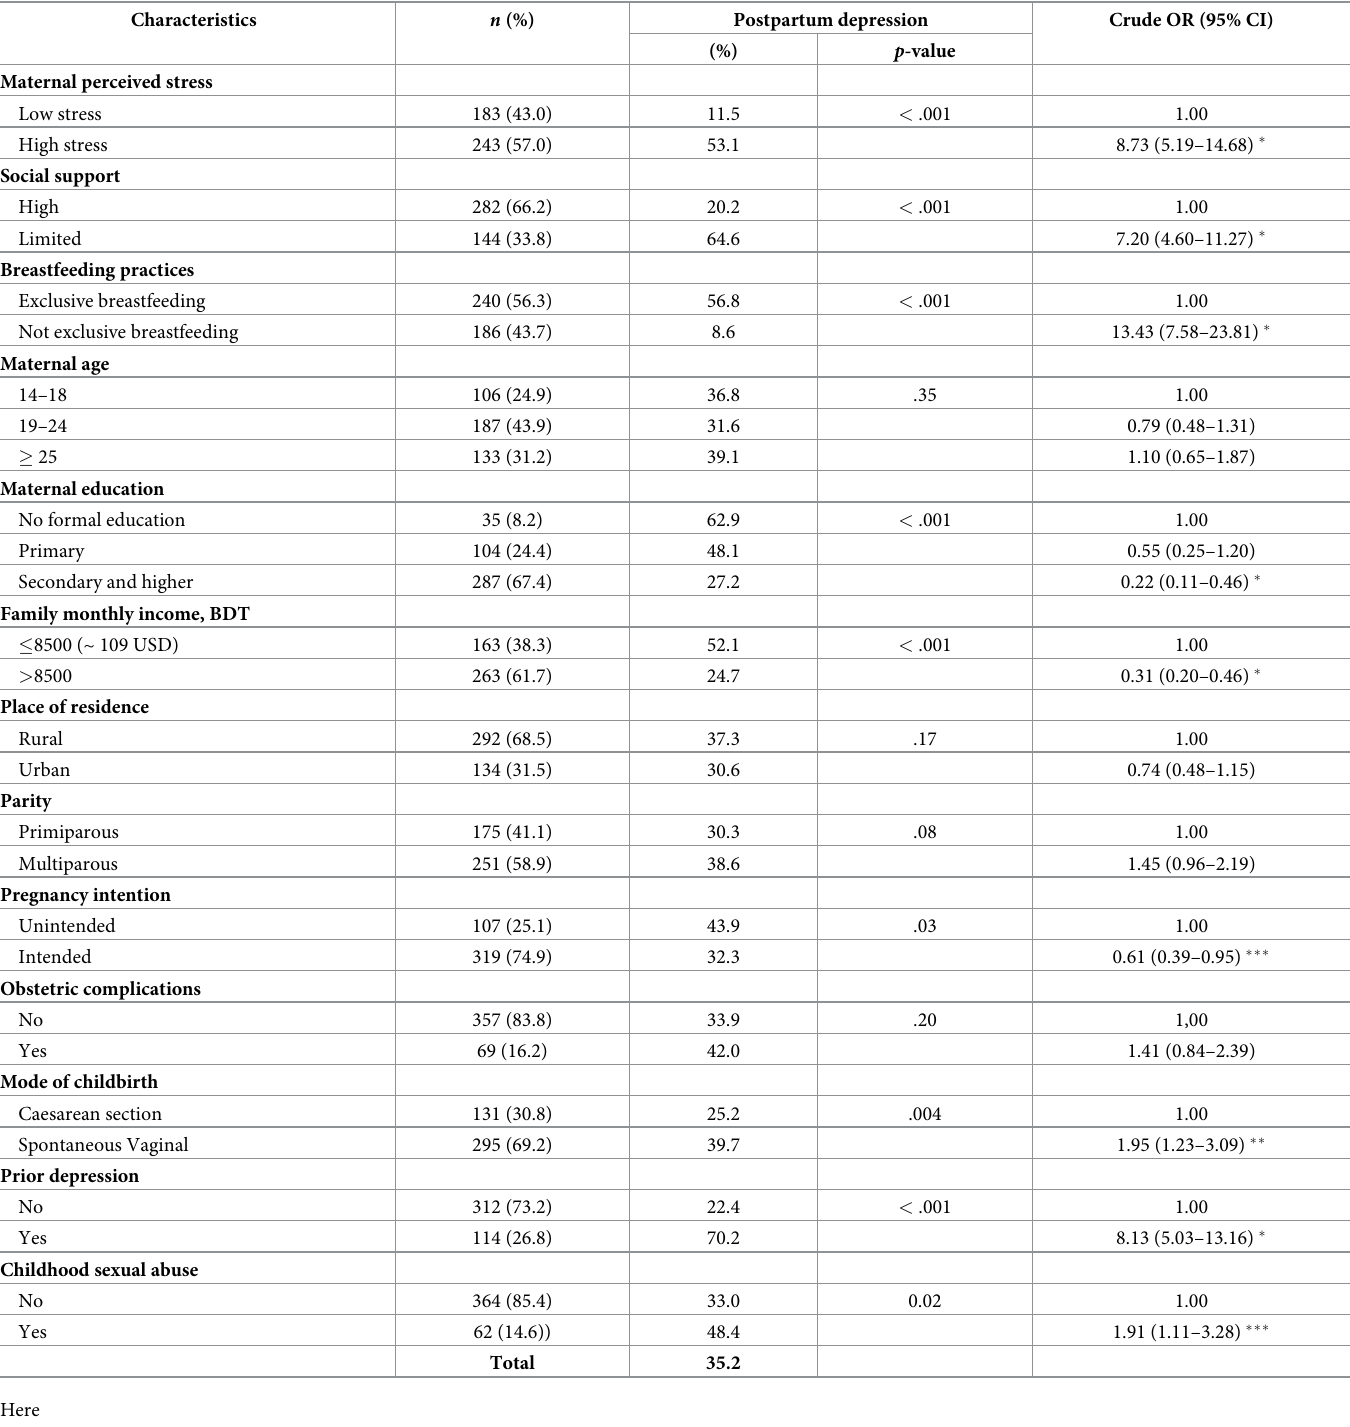
Table 1. General characteristics of the participants by the occurrence of postpartum depression and their unadjusted associations ( N =